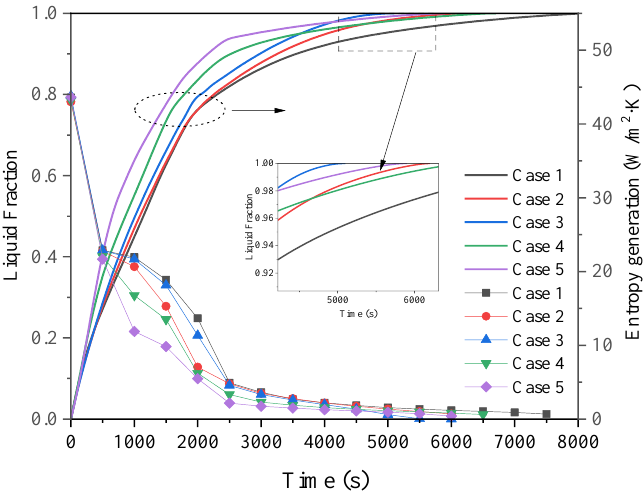
Figure 12. Thermal penetration and thermal uniformity for Cases 1 – 5.